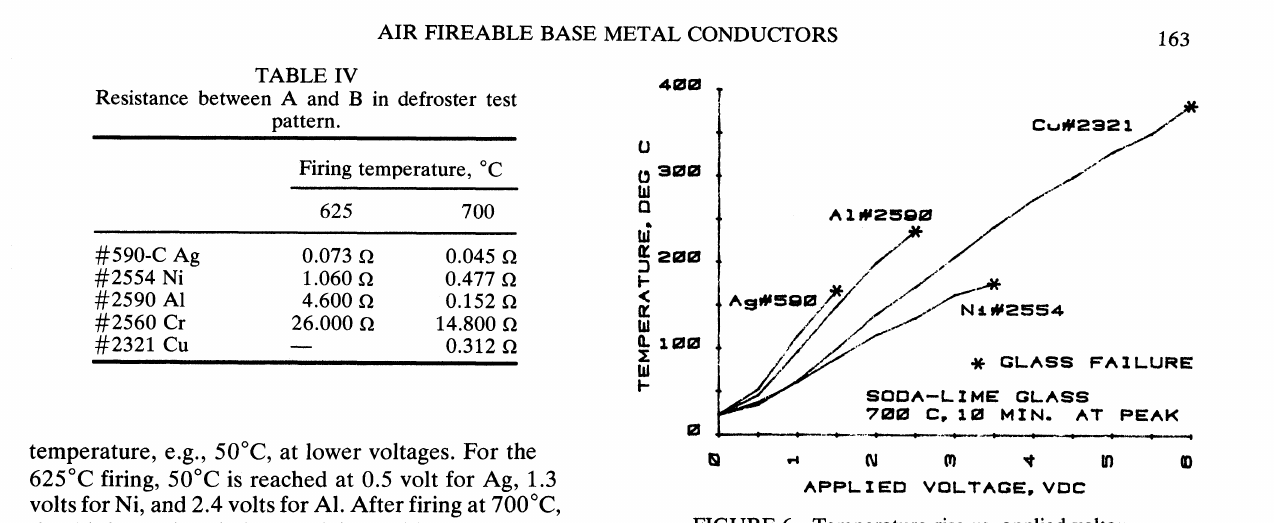
FIGURE 6 Temperature rise vs. applied voltage.